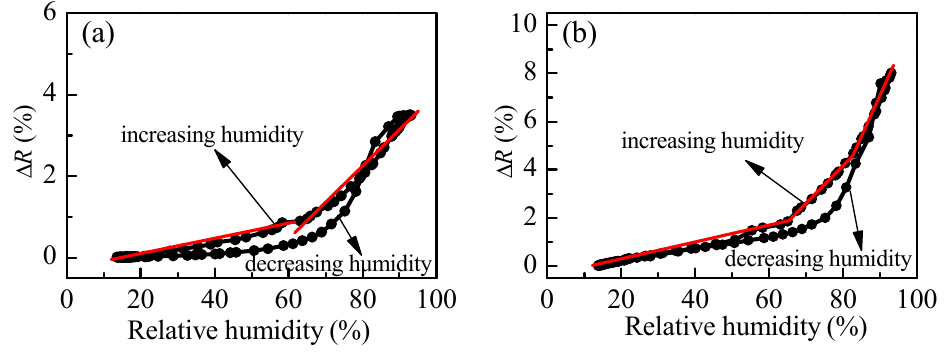
Figure 7. Variation of reflectance with humidity for P3 thin films annealed at 60 °C ( a ) and 180 °C ( b ) for 30 min after deposition.